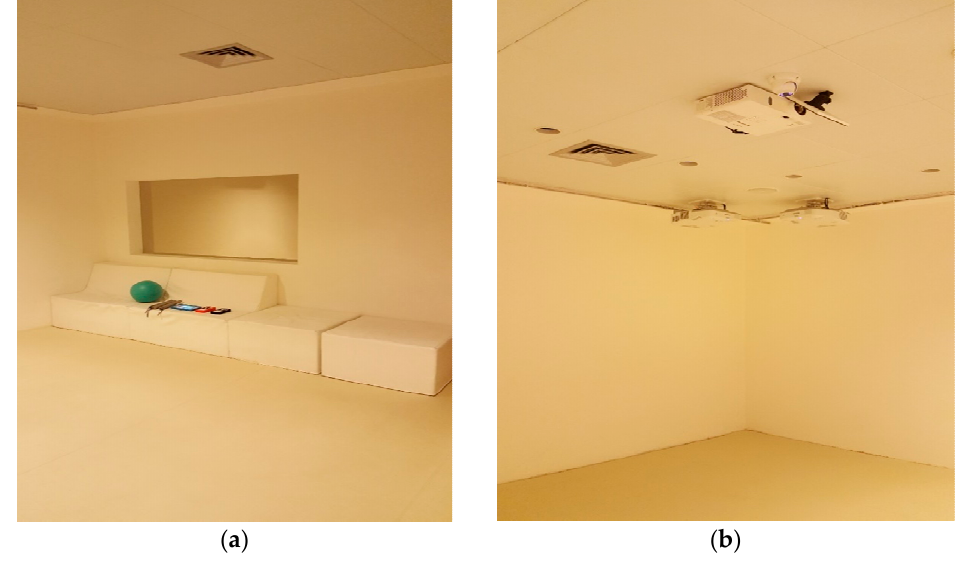
Figure 1. ( a ) Interior of the Multisensory Interactive Room, sofa and one-way mirror; ( b ) Interior of the Multisensory Interactive Room, projectors.